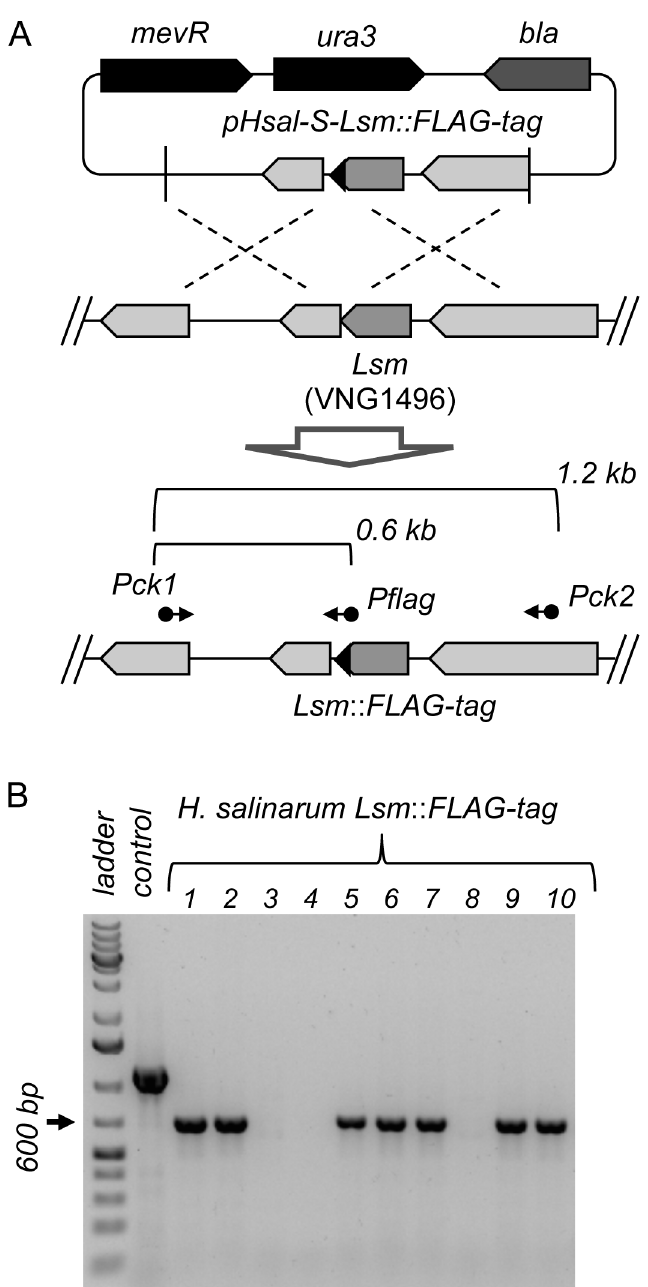
Fig 5. Construction of H . salinarum strains with chromosomal tags. (A) A suicide plasmid pHsal-S-Lsm:: FLAG-tag, harboring a modified flanking region of the Lsm gene to introduce a FLAG-tag epitope, was transformed into H . salinarum . Double recombination events were selected and correct incorporation of the FLAG-tag was checked using primers Pck1 and Pflag . As a control, primers Pck1/Pck2 were used to amplify the whole flanking region of the Lsm coding gene. ( B) PCR validation of the FLAG-tag incorporation. Ten (numbered from 1 to 10) independent colonies were selected and screened using primers Pck1/Pflag , which should give rise to an amplification band of ~ 600 bp. The 1.0 kb DNA ladder is shown on line 1, while line 2 shows the amplification control, representing the flanking region obtained using primers Pck1/Pck2